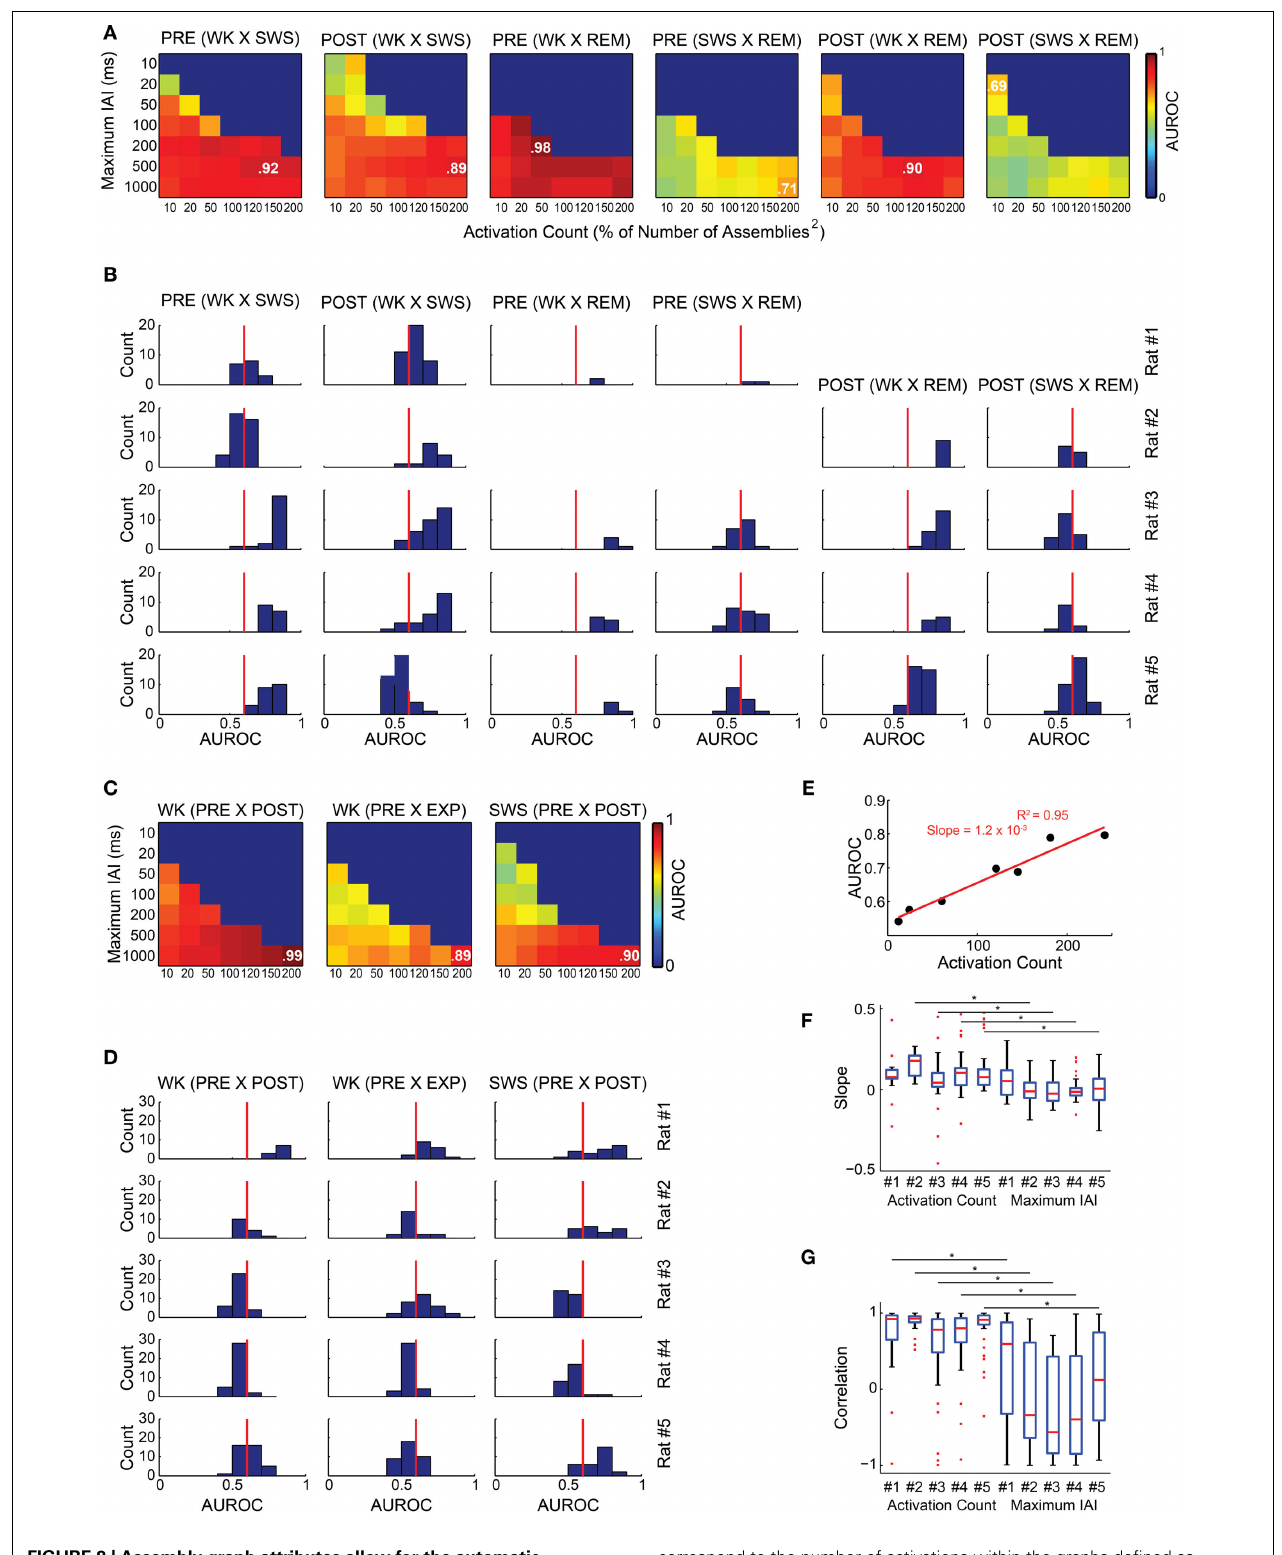
correspond to the number of activations within the graphs defined as percentages of the squared number of assemblies. Color codes vary from 0 to 1 and represent the median AUROC of 50 classifications made for 20